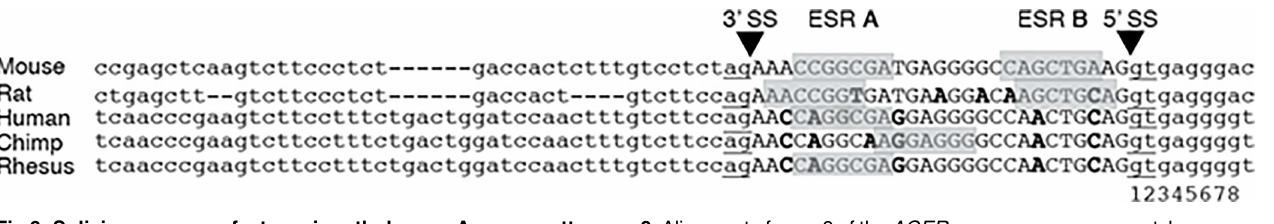
Fig 6. Splicing sequence features in orthologous Ager cassetteexon 9. Alignment of exon 9 of the AGER gene among mouse, rat, human, chimp and rhesus. Upper and lower case indicate exonic and intronic sequence,respectively. The AG and GT of the 3’SS and 5’SS are underlined. The examinedESR A and B sites are highlightedin gray. Nucleotides in bold indicate exonic positionsthat changeduring evolution.